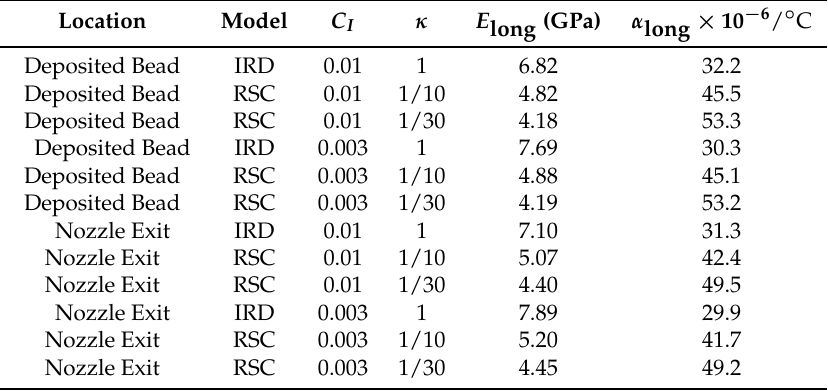
Table 1. Summary of Effective Longitudinal Properties for All Flow